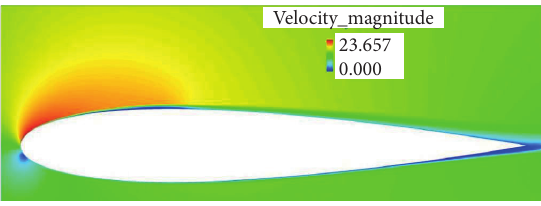
Figure 13. Velocity profile on NACA 0015 airfoil without VG in Plane 3 in Re c = 2.38 × 10 5 and AoA = 6.